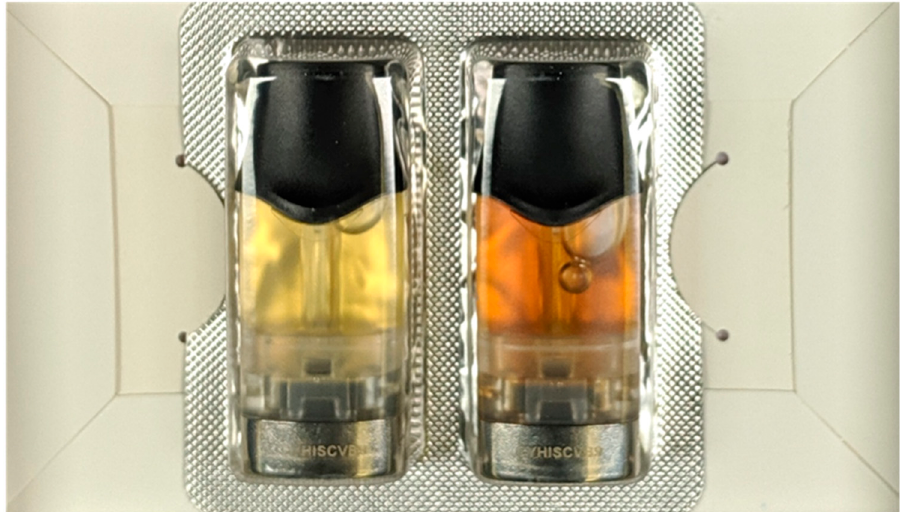
Figure 6. Nicotine flavor Vuse ALTO pods with 5.0% nicotine concentration. The two pods in the same pack have e-liquids with two different colors. The left pod was classified as light color while the right pod was classified as dark color.